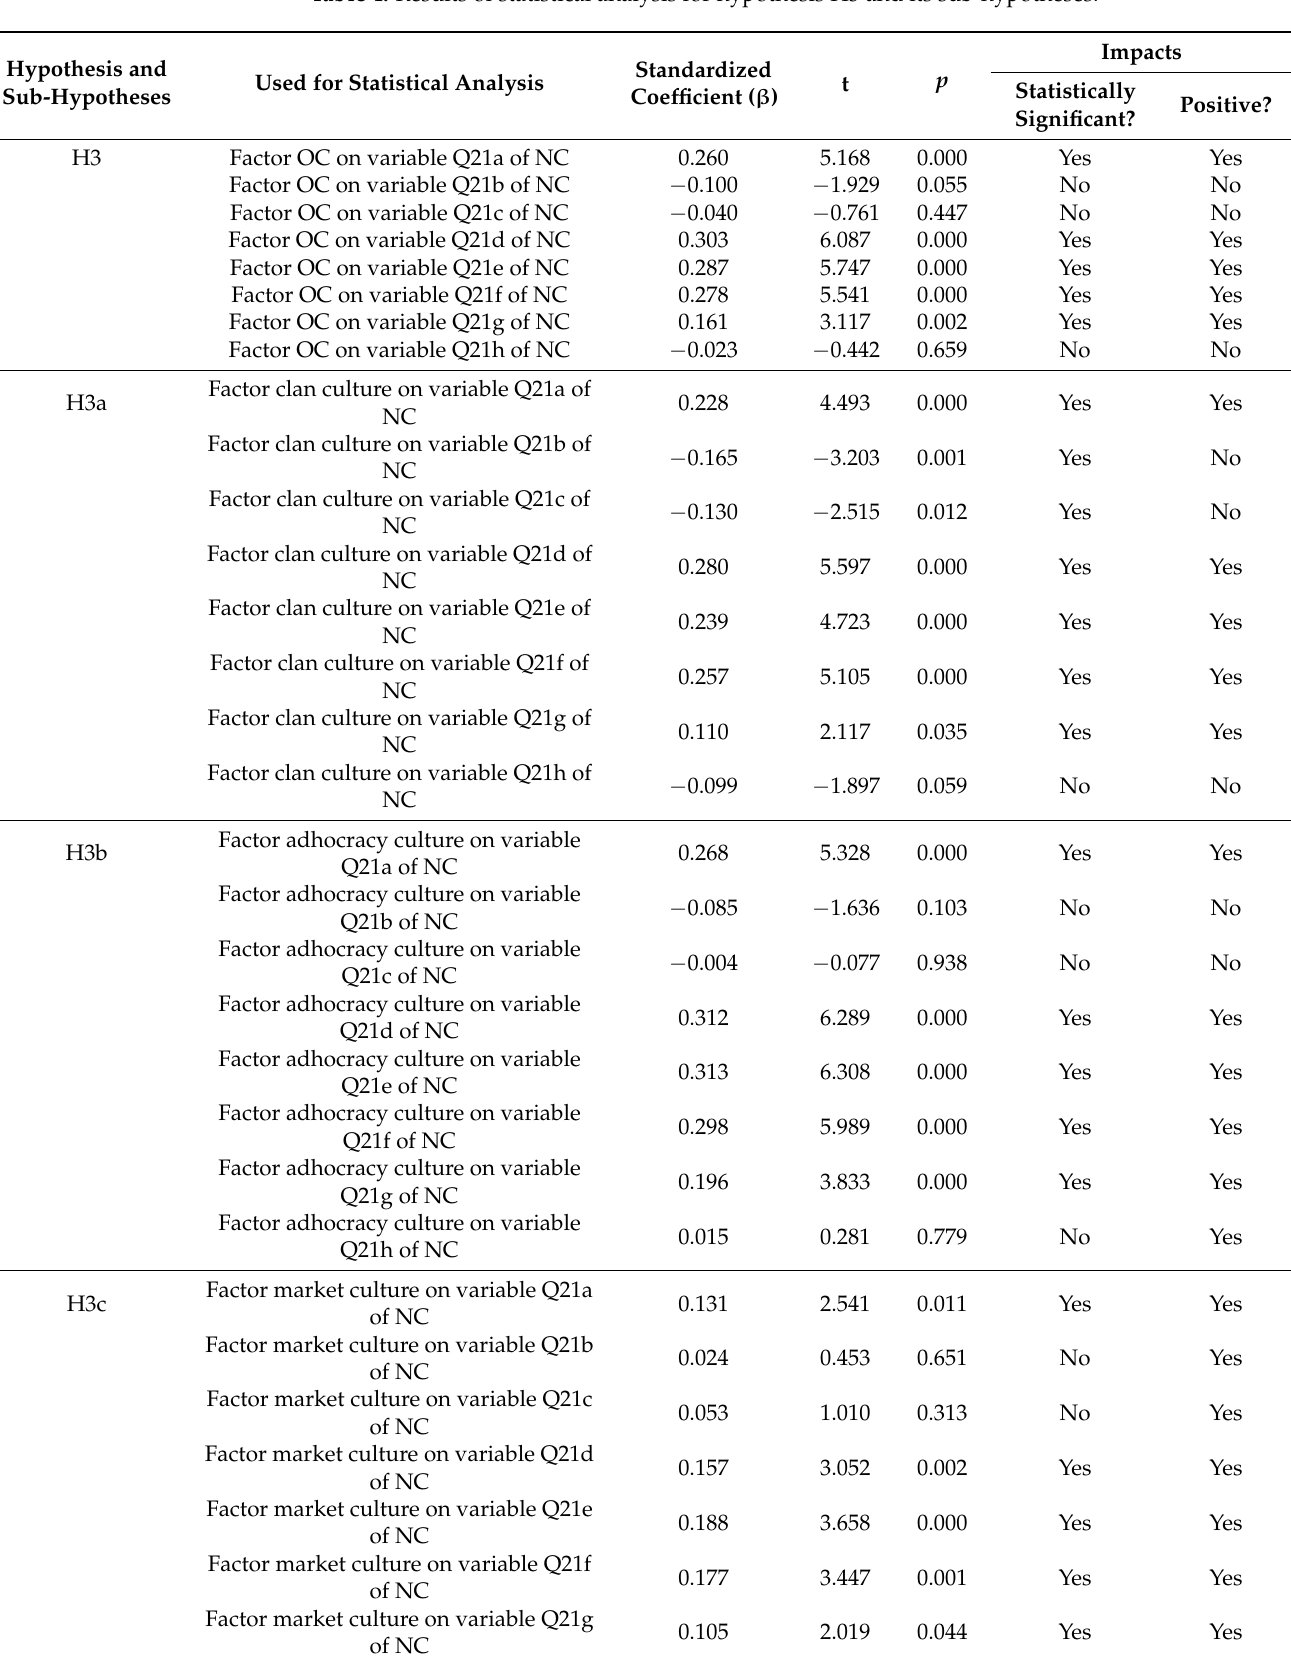
Table 4. Results of statistical analysis for hypothesis H3 and its